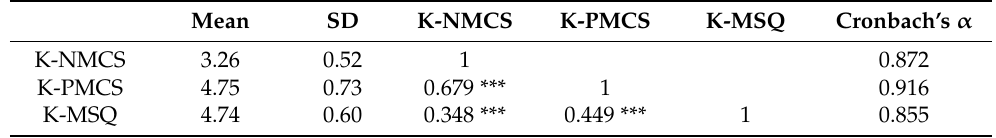
Table 4. Correlations among the K-NMCS, K-PMCS, and